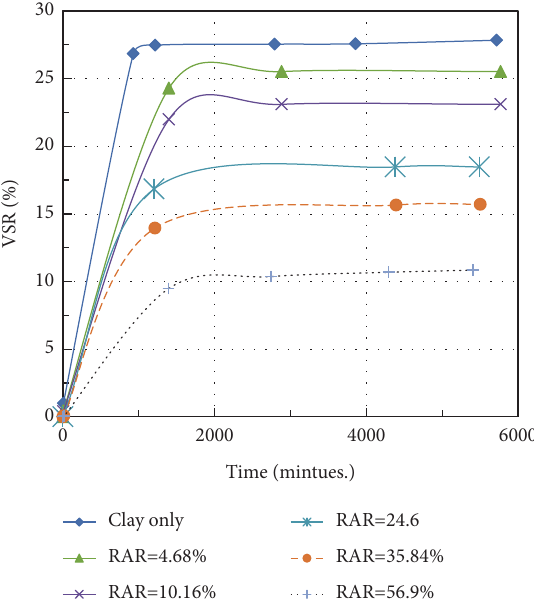
Figure 3: Variations of VSR with time for unreinforced and reinforced expansive clay soil with SP.